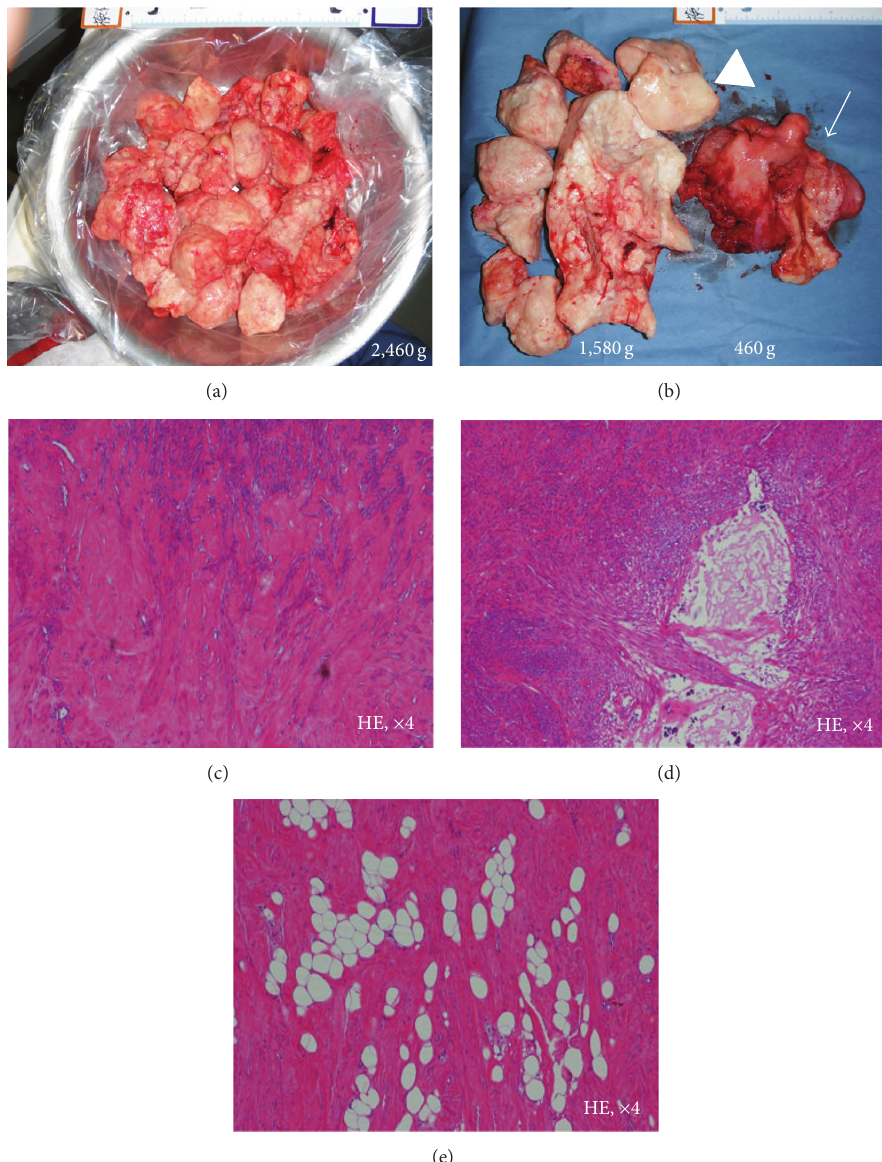
Figure 4: Macroscopic and microscopic finding of resected uterus. The weight of intramural myoma nodule resected from the corpus was 2,460 g(a),andthenoduleresectedfromtheuteruswas460 g((b)arrow),andthatresectedfromthesubserosalmyomanodulewas1,580 g((b) arrowhead);thus,thetotalweightoftheresectedmyomauteriwas4,500 g.Microscopicfindingsofmyomanoduleshowhyalinedegeneration (c), mucinous degeneration (d), and lipoleiomyoma